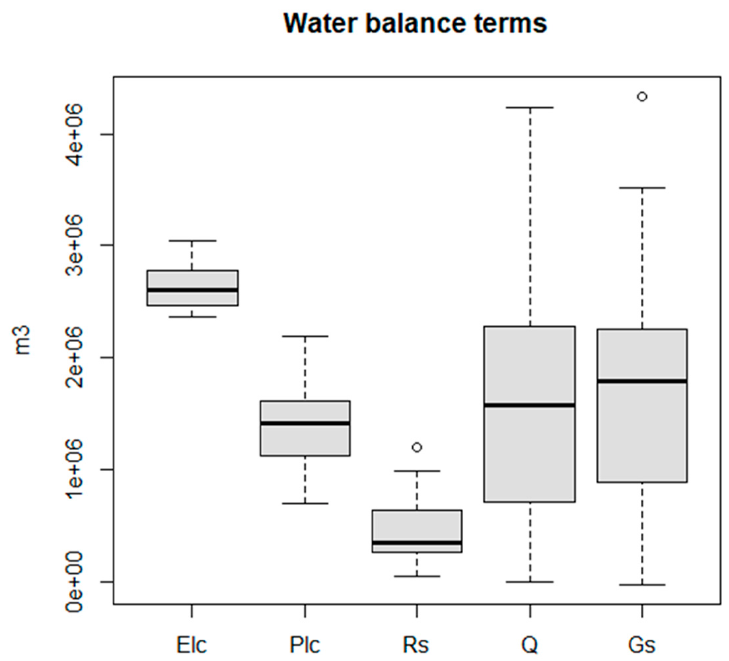
Figure 2. Boxplot distribution of the main water balance terms.